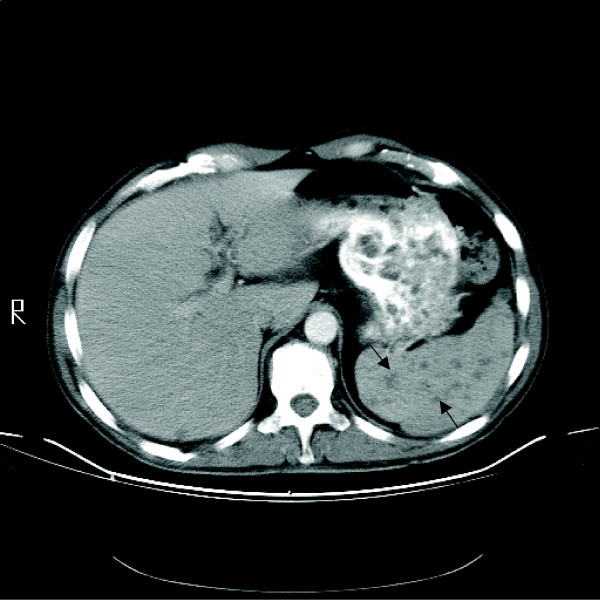
Cross sectional cut of CT scan of abdomen at the time of clinical presentation. Multiple hypoechoic densities are present in the spleen (arrows).